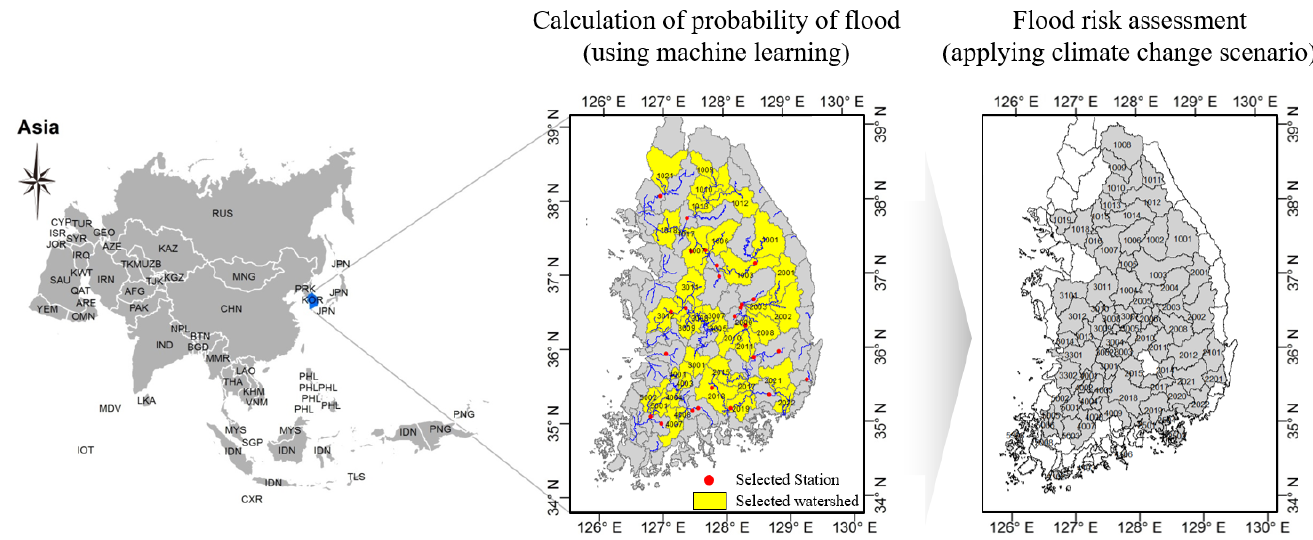
Figure 1. Range of application of flood prediction model.